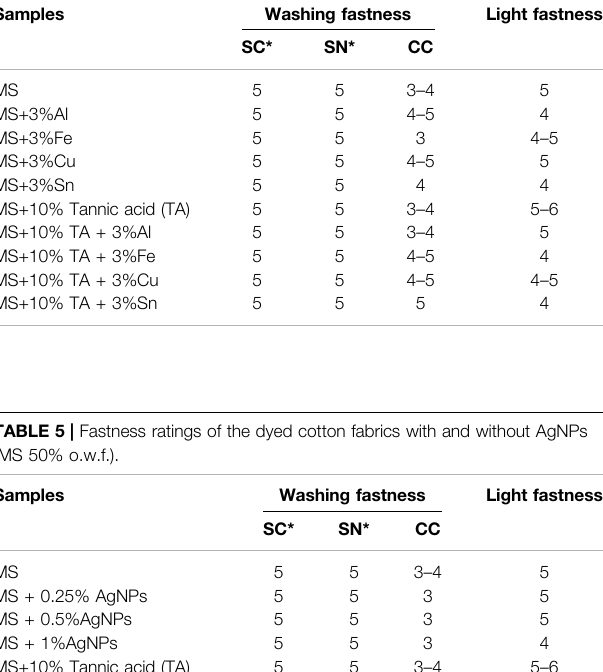
TABLE 4| Fastness ratings ofthe dyed cotton fabrics with and withoutmordants. Samples